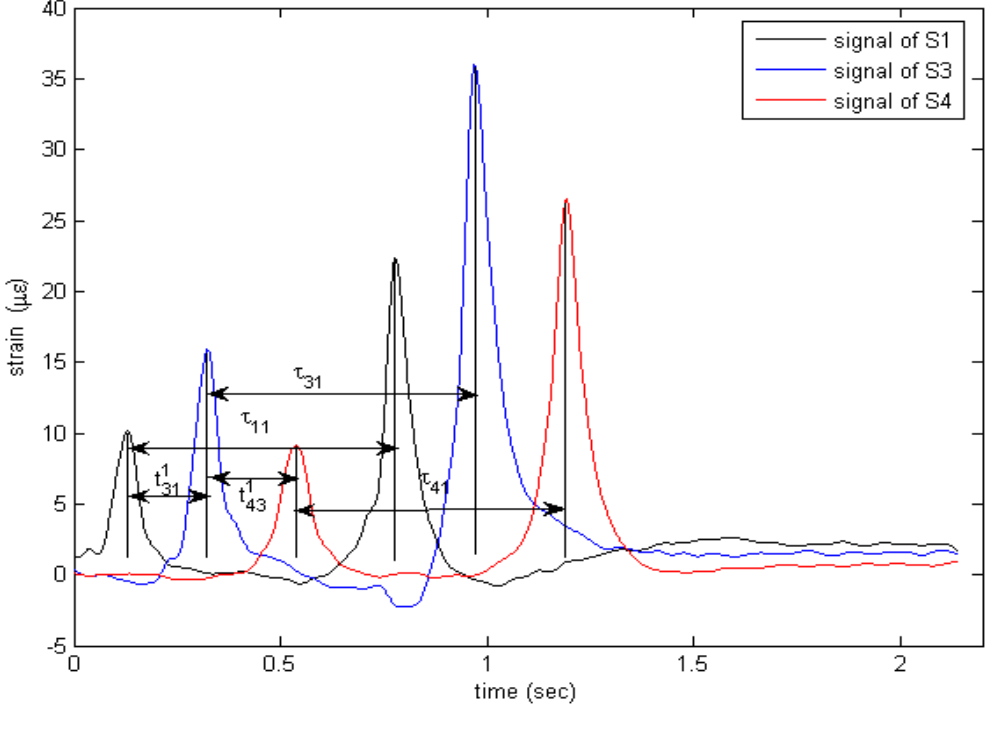
Figure 7. Vehicle classification using multiple embedded strain gauge